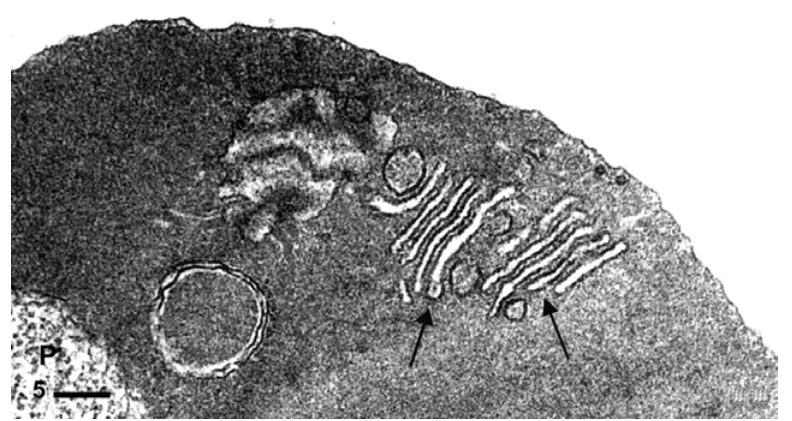
Fig. 5 – Stack offlattened lamellae (arrows), which form the Maurer’s cleft found in erythrocytes, infected with Plasmodium falciparum . P, parasite. Bar, 0 . 25 µ m. After Przyborski et al.